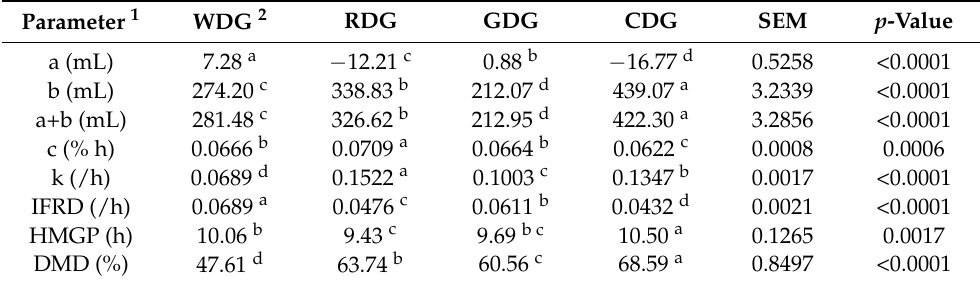
Figure 1. Total phenols, total anthocyanins and DPPH scavenging activity of four types of distiller’s grains. WDG = white distiller’s grains, RDG = red distiller’s grains, GDG = glutinous rice distiller’s grains, CDG = corn distiller’s grains, DPPH = 2,2-diphenyl-1-picrylhydrazyl. Data reported as least-squares means ± SD. a–d Different letters are significantly different ( p < 0.05). Table 2. Fermentation kinetics and degradability of four types of distiller’s